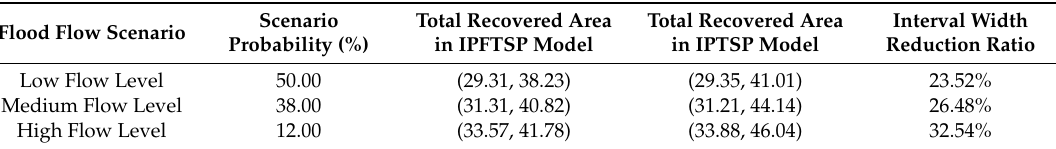
Table 6. Total recovered area of the ecological function region in the IPFTSP and IPTSP models under di ff erent flood flow scenarios (10 3 ha).